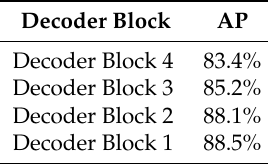
Table 4. The AP for magnified convolutional features based on different decoder